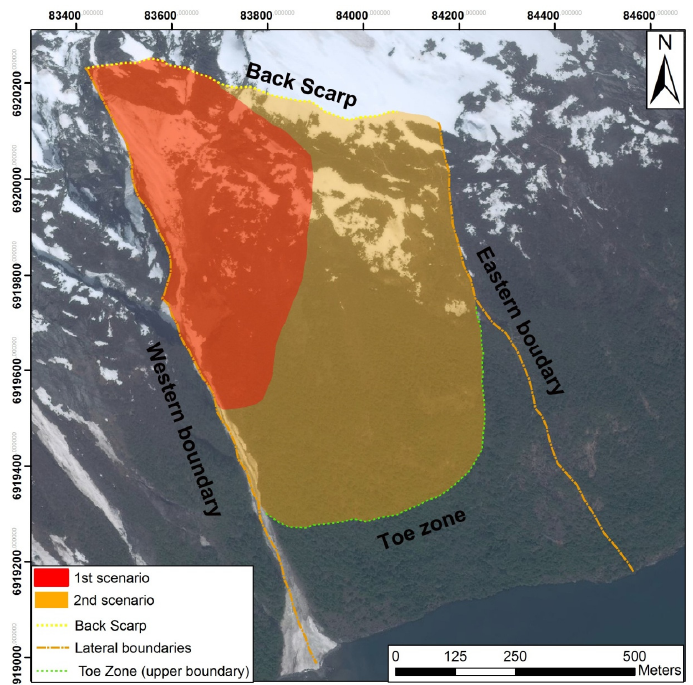
Figure 4. Rockslide distinction in two different risk scenarios and its delimitation taking into account the main detected geomorphological features [44,50].